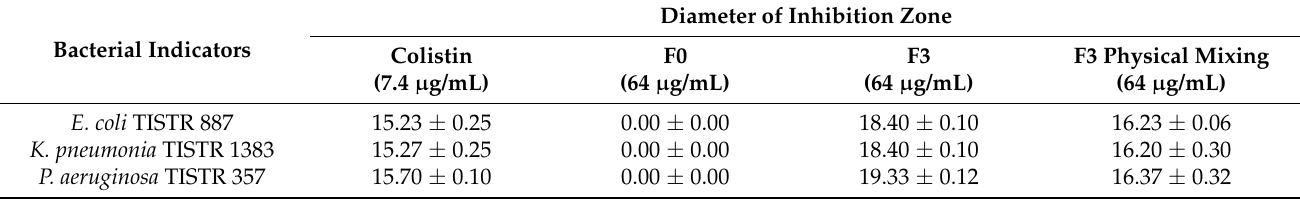
Table 3. Agar well diffusion assay for nanoparticles. Inhibition zone of colistin, AgNPs in F0, and Col-AgNPs in F3 and F3 physical mixing against E. coli TISTR 887, K. pneumonia TISTR 1383,